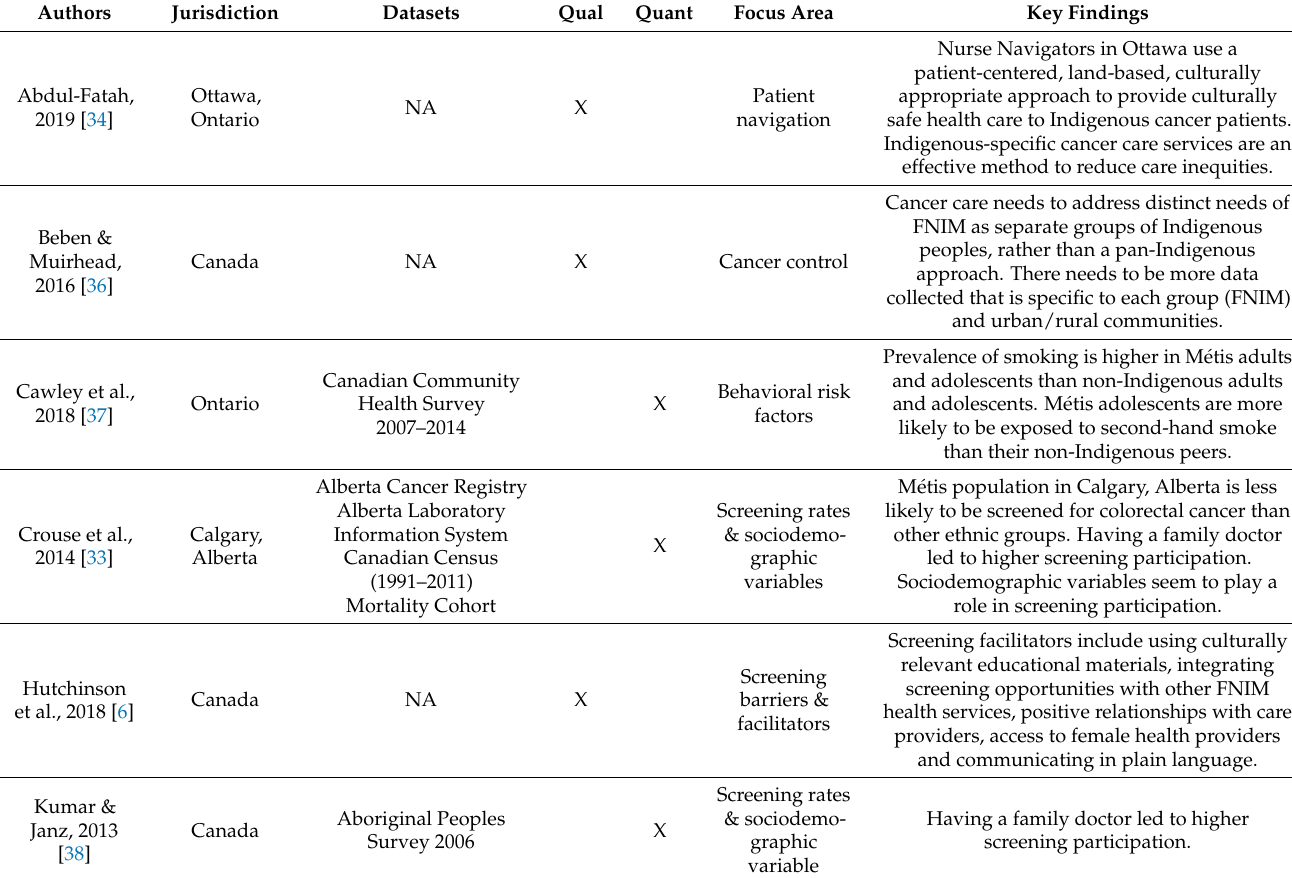
Table 4. Jurisdiction covered, datasets used, method type, focus area and key findings of academic